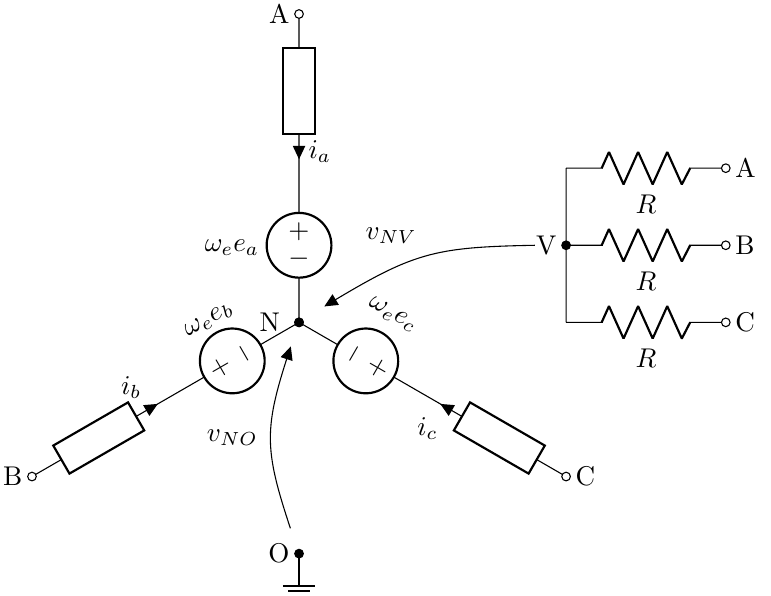
Figure 1. Schematic of a synchronous machine with accessible star-point N. V is the virtual star-point used for the DFC